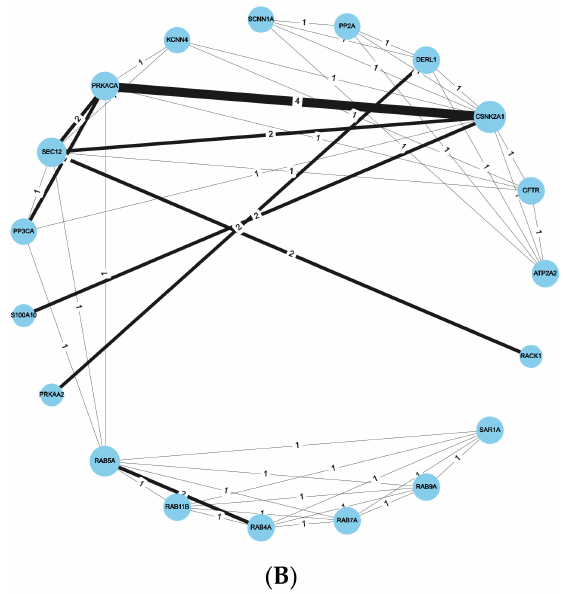
Figure 4. Results of method I using both docking programs combined, including and excluding PRKACA and CSNK2A1. ( A ): Number of targets associated with each ligand. ( B ): Protein–Ligand- Interaction network. Each nodes (circle) stands for one target, while the edges (lines) connecting them represent the number of common ligands (=number on edge) associated with them by either method. The thicker the edge, the more ligands two targets share. The size of the nodes represents their degree, i.e., the number of other nodes they are connected to.